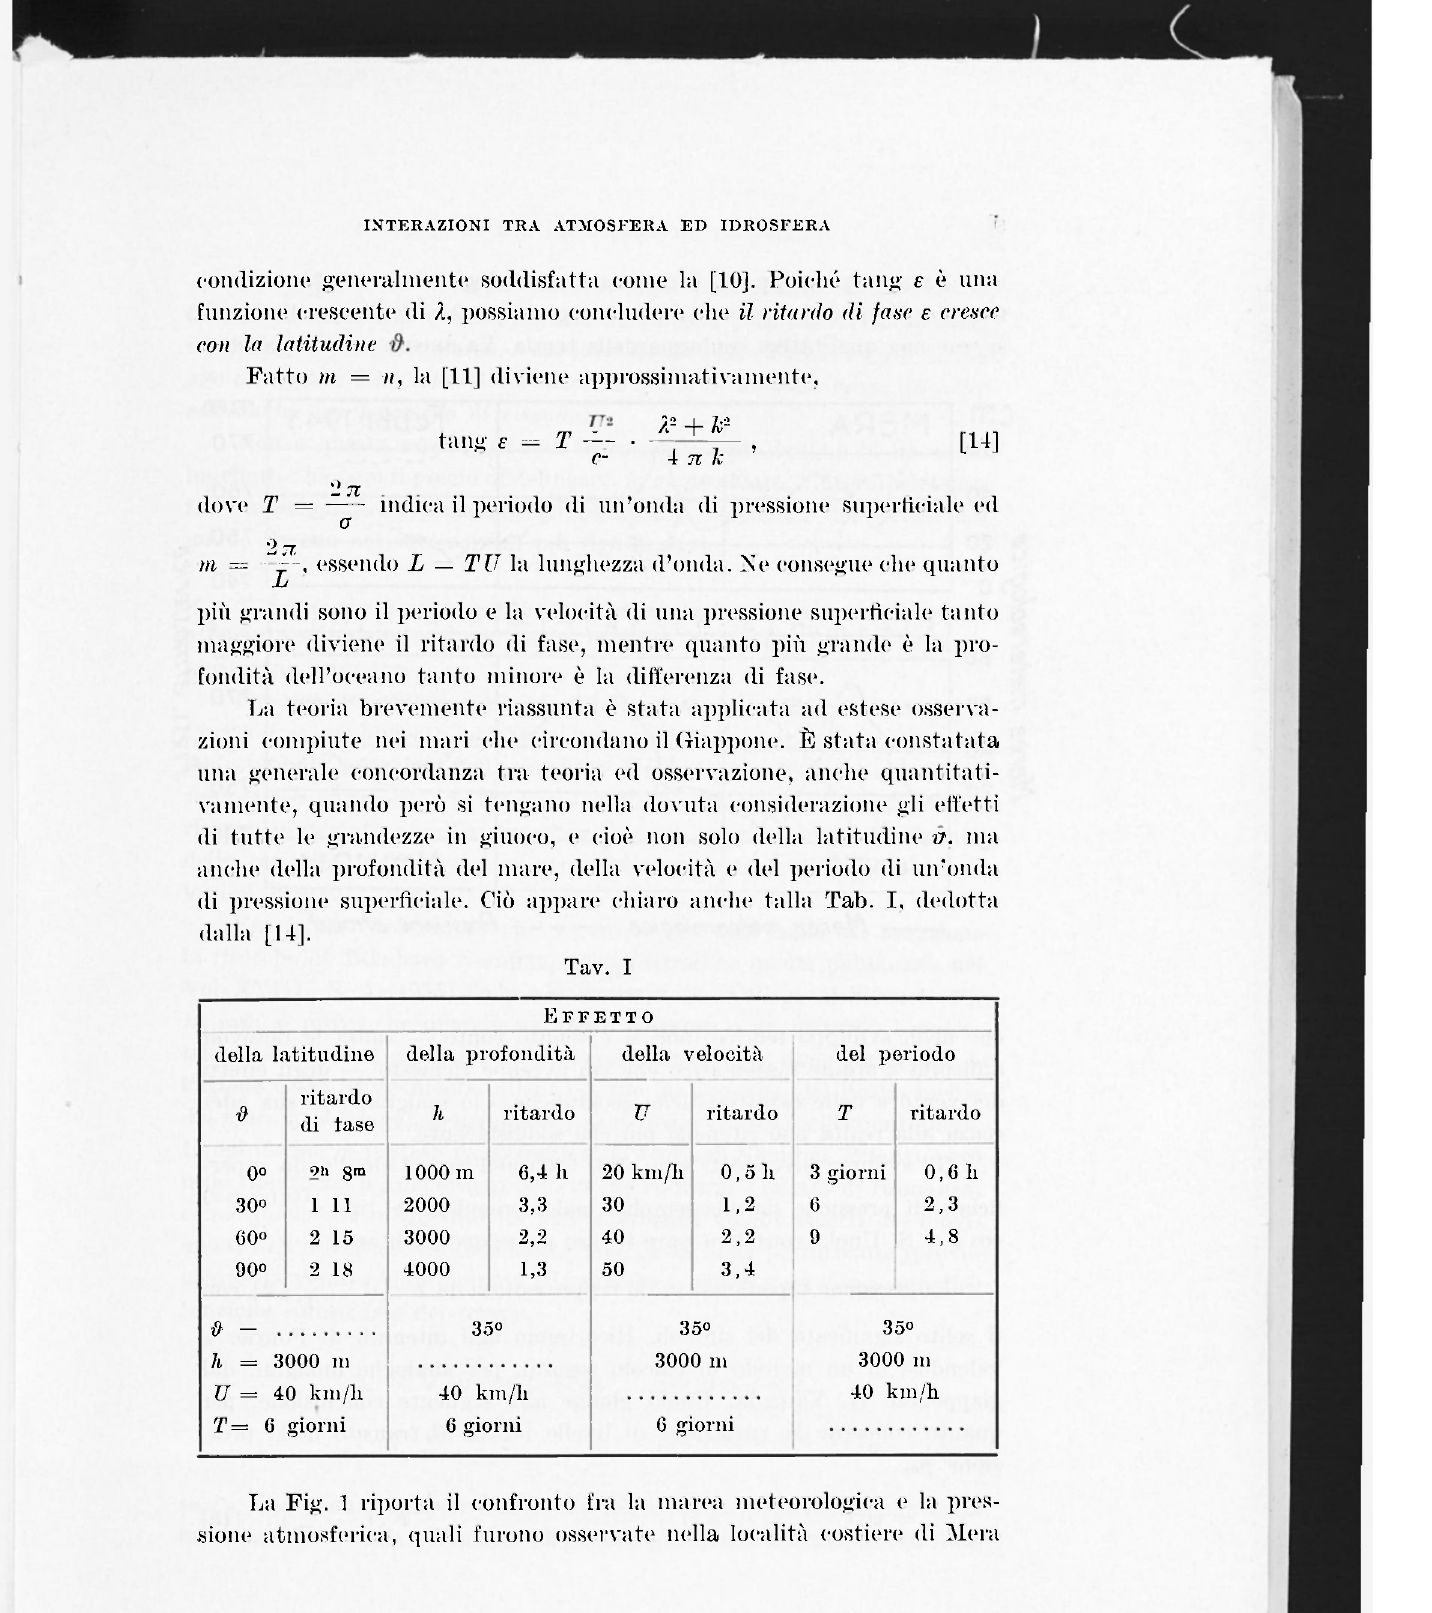
La Fig. 1 riporta il confronto fra la marea meteorologica e la